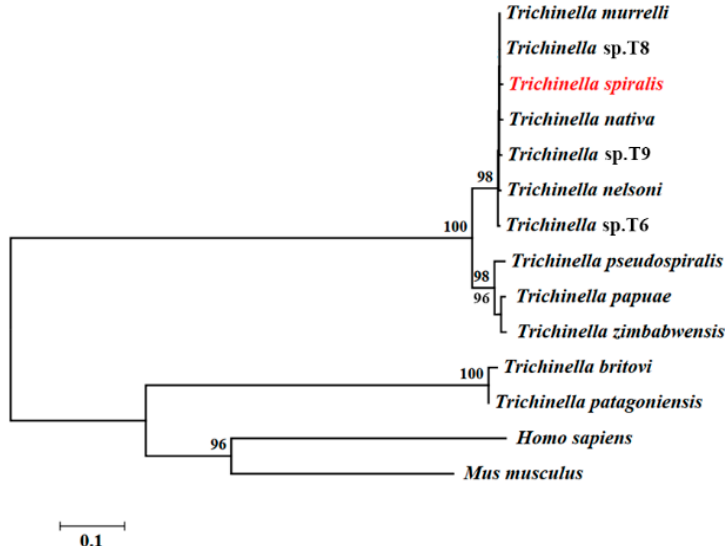
Figure 2. Sequence alignment of Trichinella spiralis trypsin gene (GenBank: XP_003374437.1) with other Trichinella species/genotypes and Trichuris suis . The sequences of trypsin from various organisms were analyzed using Clustal W, the obvious difference was found in diverse Trichinella species or genotypes. Black shade represents the same residues with TsT, and grey shade indicates the conservative substitutions.